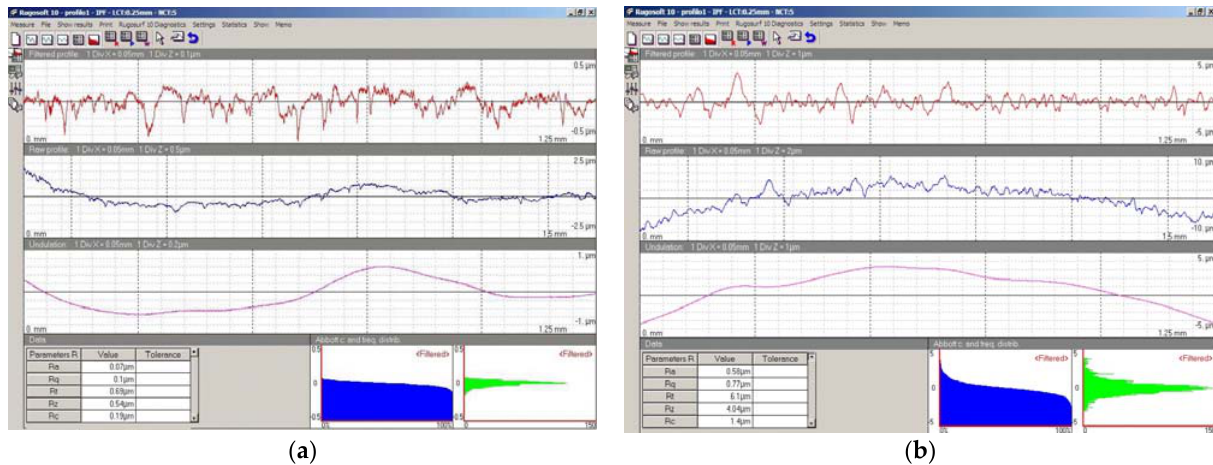
Figure 6. An example of the effect of sandblasting process in the roughness profile and parameters: ( a ) pre-sandblasted Ø 25 mm sphere, original G100; ( b ) post-sandblasted Ø 25 mm sphere.